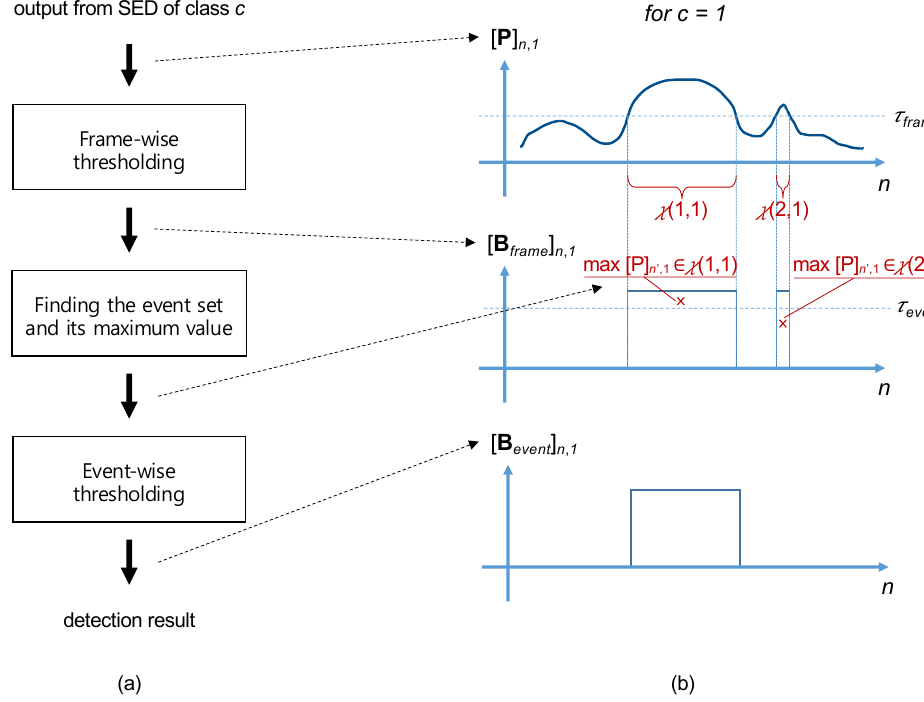
Figure 6. ( a ) A flow chart; and ( b ) an illustrative example of the event-wise